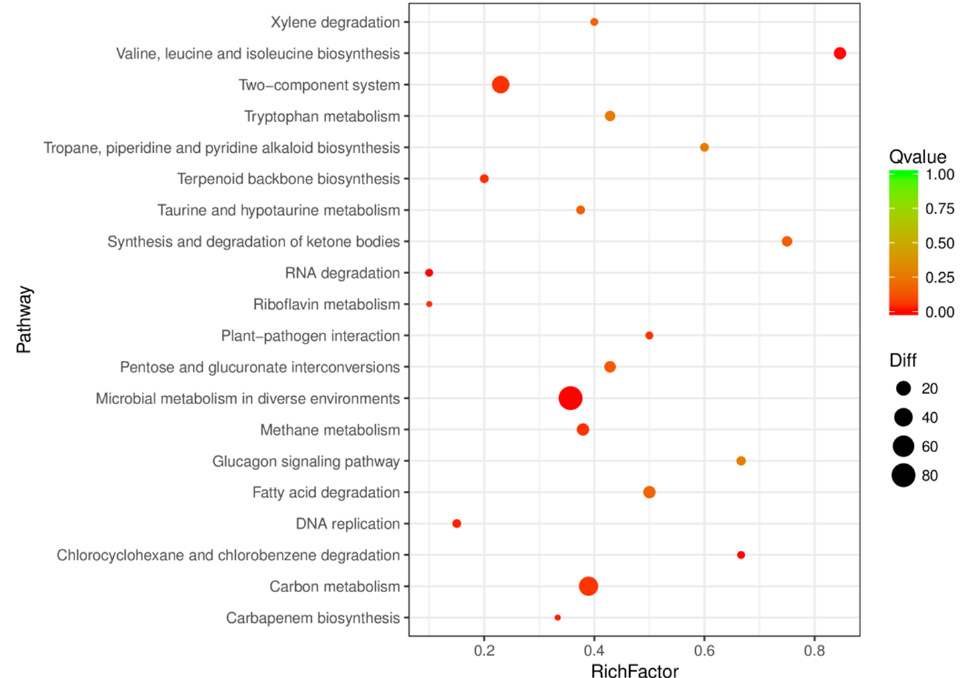
Figure 4. KEGG classification of the differentially expressed genes of Bacillus velezensis CMT-6. RichFactor refers to the ratio of the number of differentially expressed genes annotated in the pathway term.